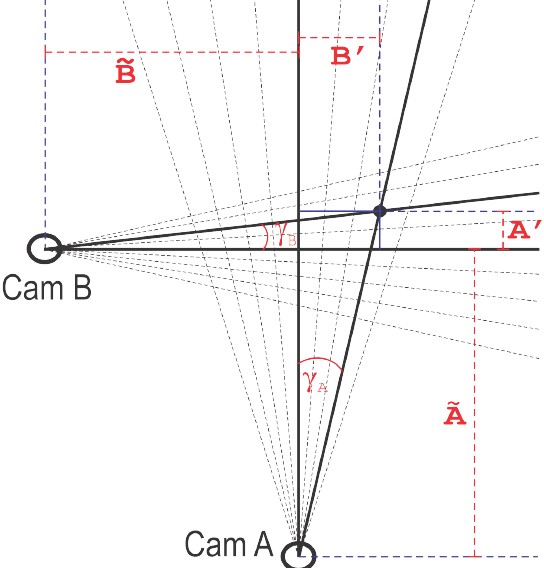
Figure A1. An illustration of the basic coordinate system used to find the area for each pixel, drawn for a simplified 8 pixel × 8 pixel geometry. Following the notational conventions established in the appendix, the dotted exemplar vertex corresponds to m = 3 and n =